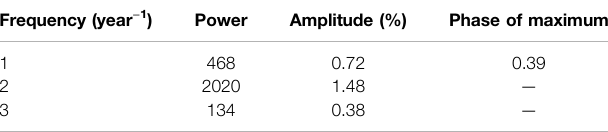
TABLE 2 | The annual oscillation and the leading two harmonics as derived from the midnight-centered